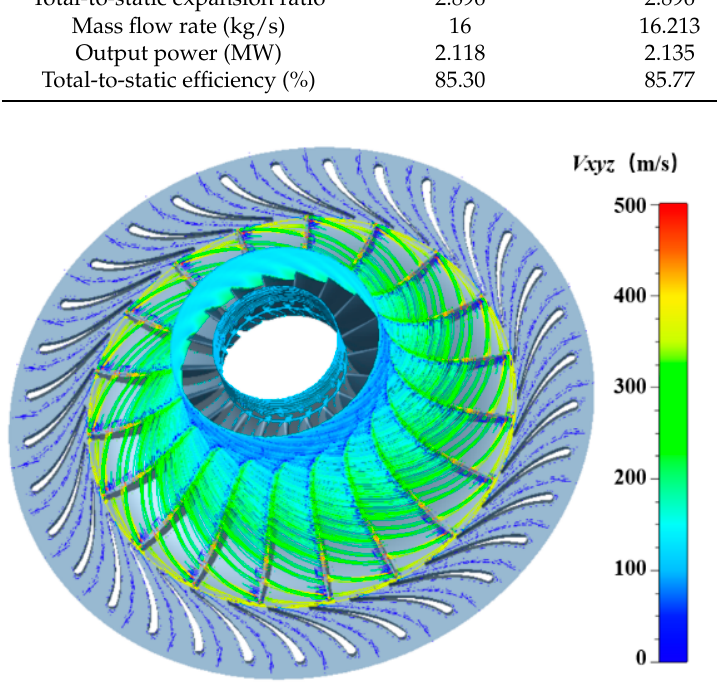
Figure 5. Streamlines in the nozzle and rotor passages.